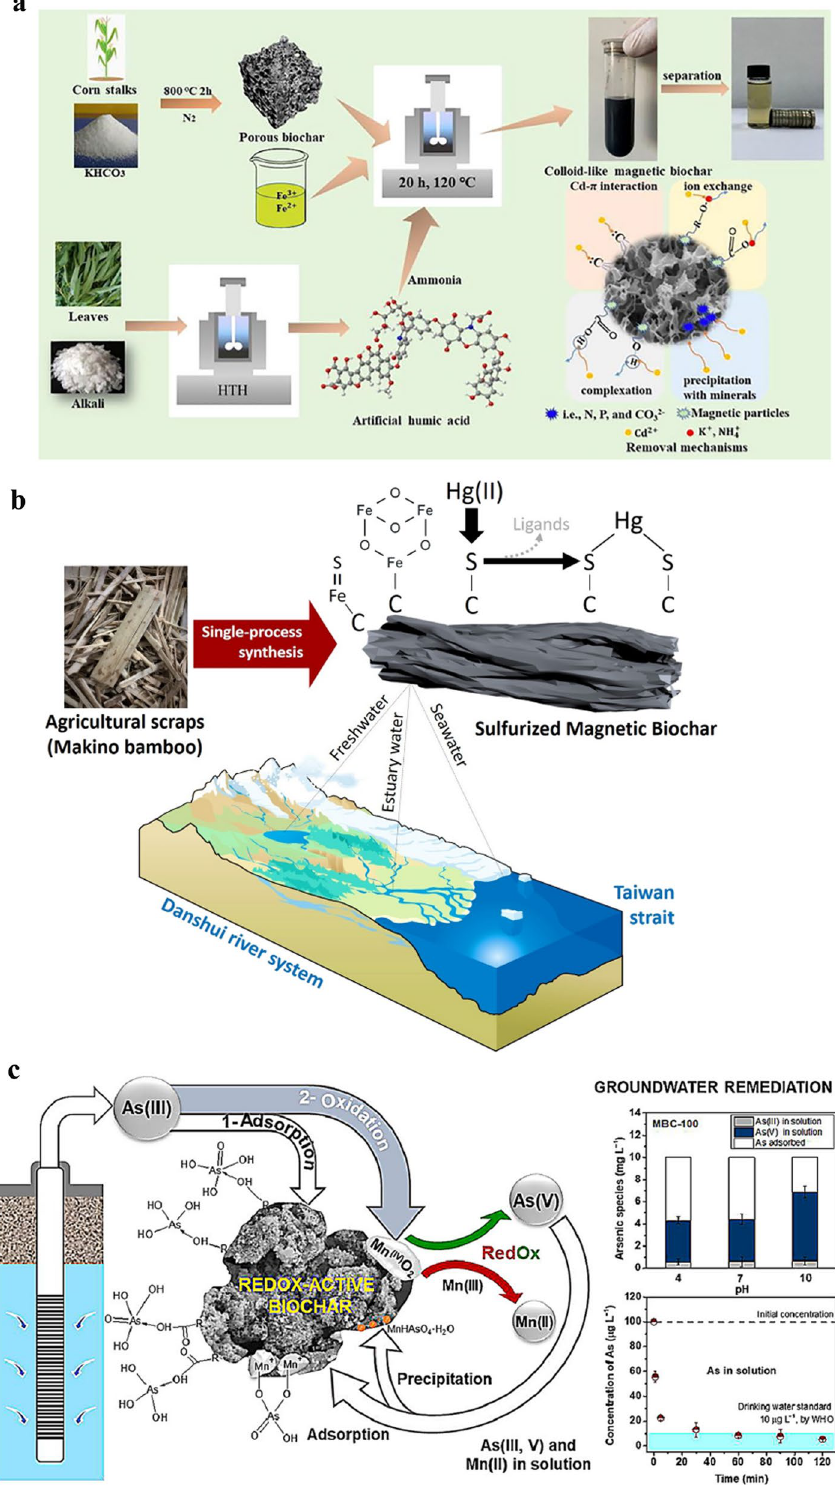
Fig. 3 Possible pathways for the removal of toxic metals by biochar. Cd removal mechanisms by functional colloid-like magnetic biochar ( a ) (Yang et al. 2021c); Hg(II) removal mechanisms by sulfurized magnetic biochar ( b ) (Hsu et al. 2021); As(III) removal mechanisms by MnO 2 -biochar composite ( c ) (Cuong et al.